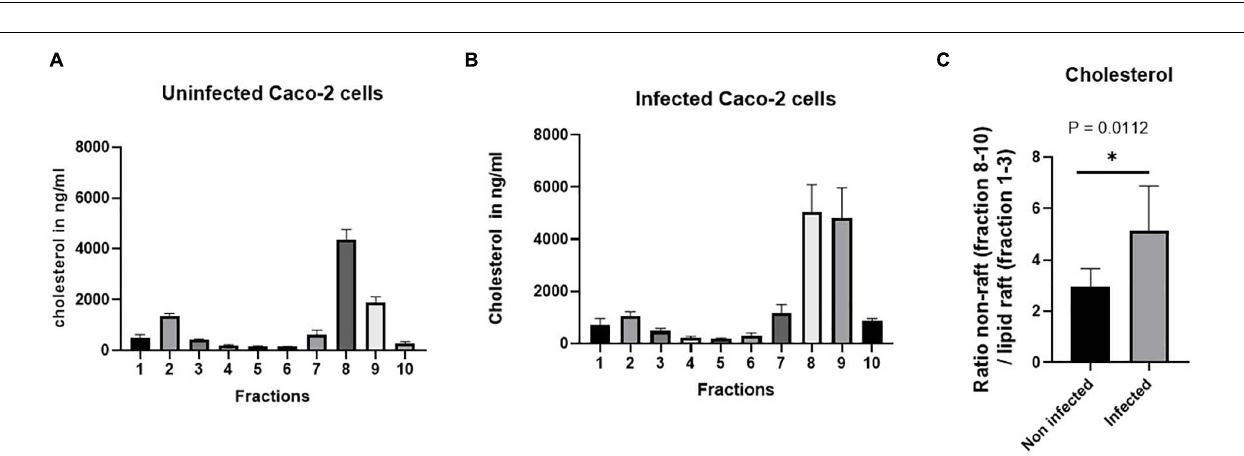
FIGURE 5 | Lipid rafts (LRs) are altered in Caco-2 cells infected with Staphylococcus aureus Newman. Control non-infected or S. aureus infected Caco-2 cells were solubilized with 1% (w/v) Triton X-100 and separated on sucrose density gradients. Ten fractions were collected and used for further analysis in which the LRs are found in the top fractions (fractions 1–3) due to their low buoyant density. The distribution of the LR markers flotillin-2 (FLOT-2) (A) and sucrase–isomaltase (SI) (B) in the bottom three fractions (non-rafts) and in the top three fractions (LRs) in the control non-infected cells was compared with that of respective values from the same fractions in cells infected with S. aureus using by Western blotting. Raw data are shown in Supplementary Figures 5 , 6 . The redistribution suggests an altered LR composition in S. aureus -infected Caco-2 cells. Statistical significant differences are shown as ** p < 0.01 or *** p < 0.001.